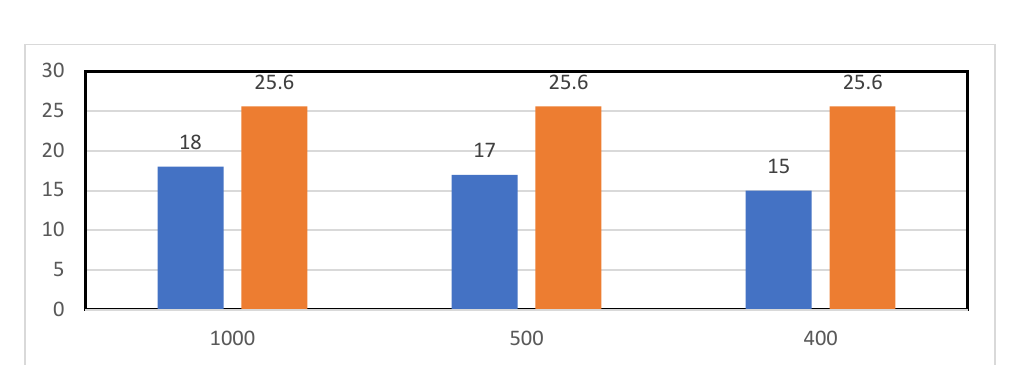
Figure 8. Voltage at MPP of solar panel vs output voltage of solar battery charger under various condition of solar irradiance.